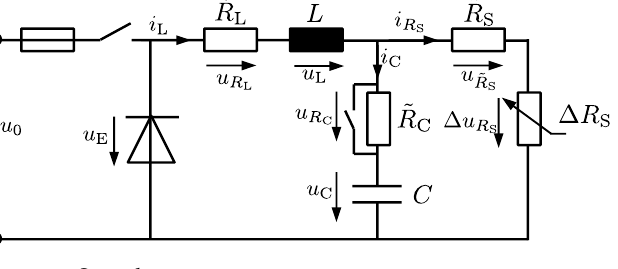
Figure 2. Step-down